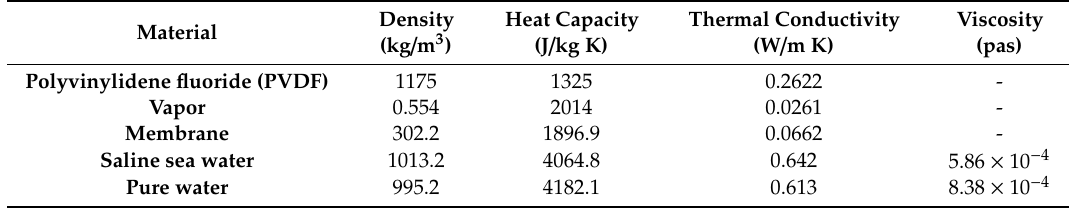
Table 1. Physical and thermal and properties of the membrane modeled in the present study taken from the literature